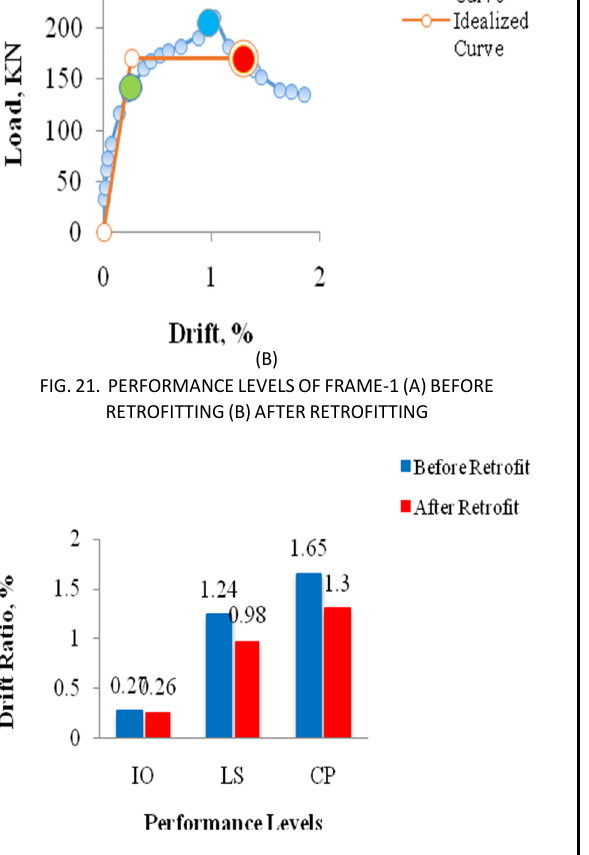
FIG. 22. COMPARISON OF PERFORMANCE LEVELS OF FRAME-1 BEFORE AND AFTER RETROFITTING